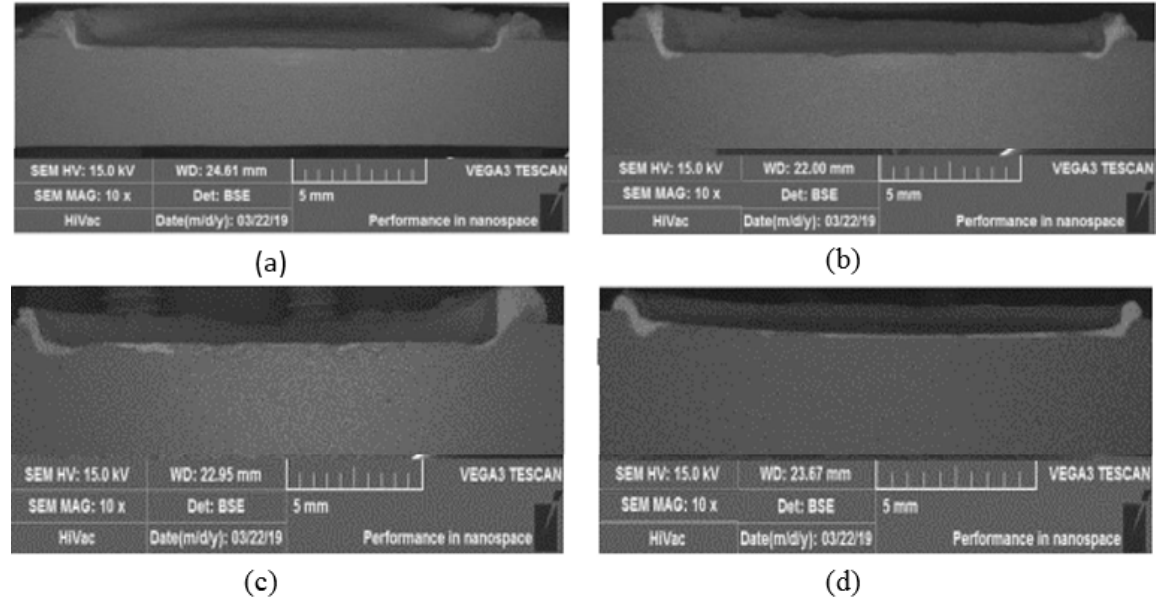
Figure 3: Cross sections of friction stir-processed AA1100 with various Zn particle volumes of (a) 22 mm 3 , (b) 45 mm 3 , (c) 67 mm 3 , and (d) 90 mm 3